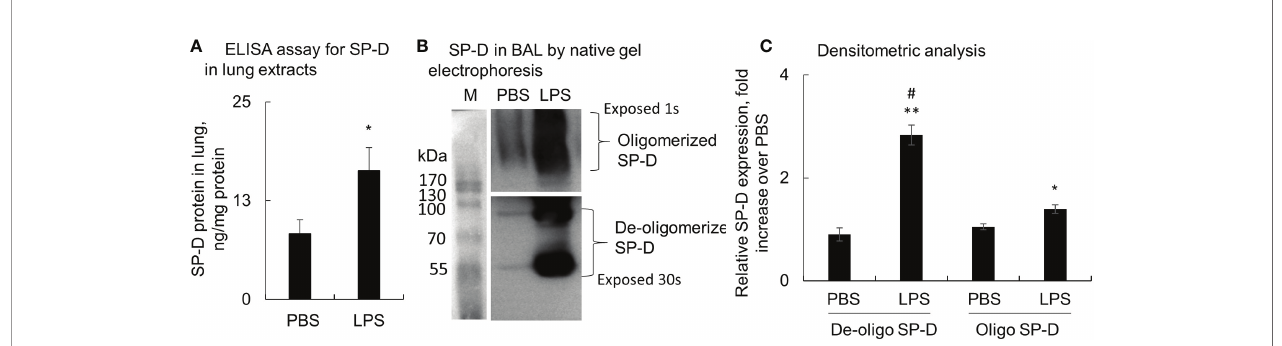
FIGURE 1 | Lipopolysaccharide (LPS) induced more de-oligomerization of surfactant protein D (SP-D) in mice with acute lung injury (ALI). Mice with ALI were established by intratracheal (i.t.) administration of 5 mg/kg LPS for 2 days. (A) SP-D content in lung protein extracts was measured by ELISA. Value was normalized to the total protein amount in lung extracts and presented as mean ± SE, *p < 0.05 vs . those in mice treated with PBS control, n = 5. (B) SP-D structure in bronchoalveolar lavage (BAL) of phosphate buffered saline (PBS) and LPS-treated mice was analyzed by native gel electrophoresis. Multimeric or oligomerized SP-D was on the top of the gel. The de-oligomerized SP-D was resolved as 86 and 43 kDa. (C) Quantitative analysis of de-oligomerized and oligomerized SP-D by measuring densitometric value on ImageJ software. Data was presented as fold increase of each form of SP-D densitometric value in LPS group over those in the